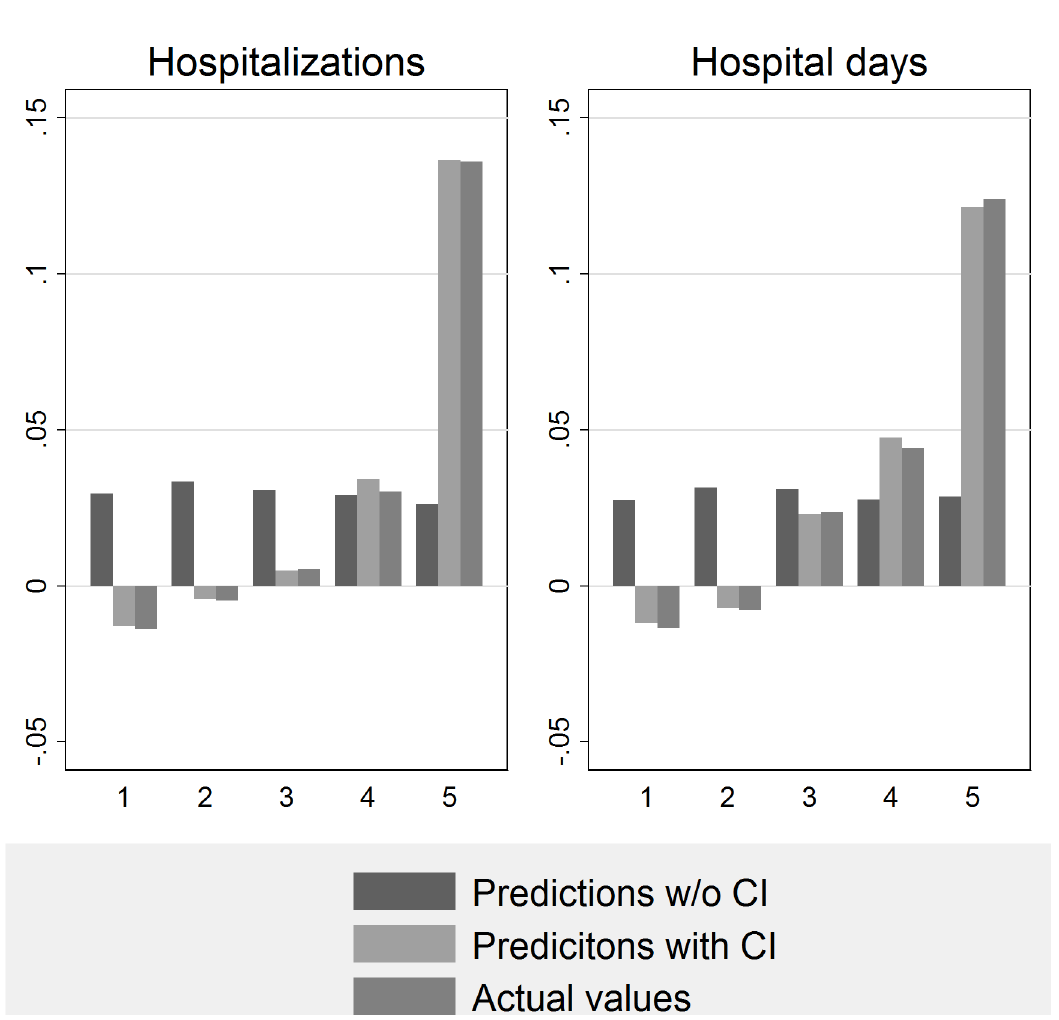
Fig 2. The actual and predicted % changes in hospitalizations and hospital days, by quintiles of crisis intensity. Predictions without Crisis Intensity (CI) do not include dummies for the quintiles of